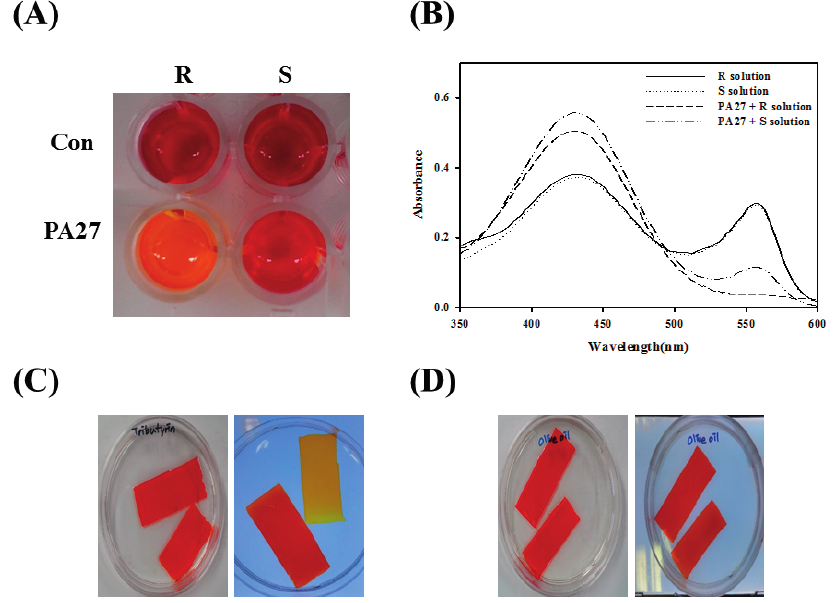
Figure 2. ( A ) pH shift assay was conducted in the presence of ( R )- or ( S )-methyl ( R )-3-hydroxy-2-methylpropanoate; ( B ) The absorbance spectrum of each solution after 1 h was measured; ( C , D ) Activity staining of PA27 in non-denaturing gel towards glyceryl tributyrate (C) and olive oil (D).